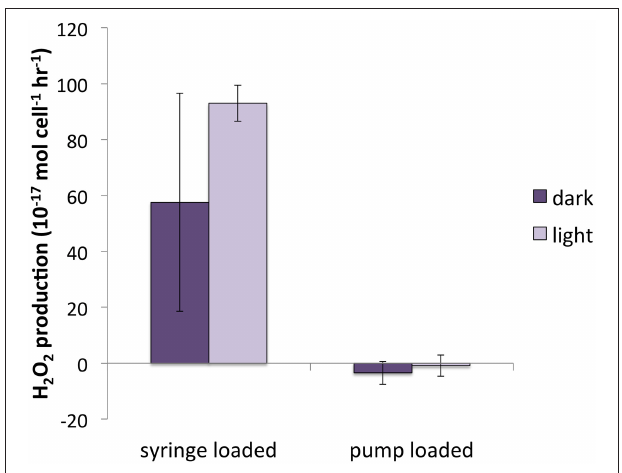
FIGURE 7 | H 2 O 2 production for pump-loaded vs. syringe loaded cultures of T. weissflogii .